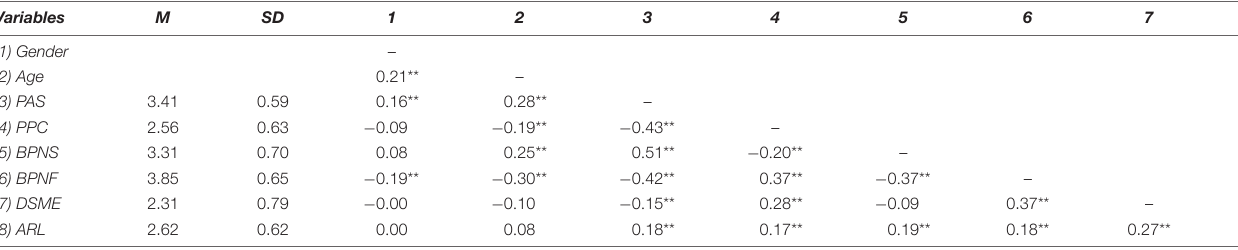
TABLE 2 | Descriptive statistics and correlations of observed variables.